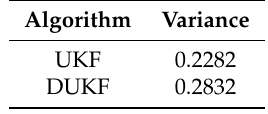
Figure 4. The computational time of UKF and DUKF during the 1000 Monte Carlo simulations of a simple model, where blue asterisks represent the calculation time of DUKF, while the red circles stand for that of UKF. Table 2. Variance of the UKF and the